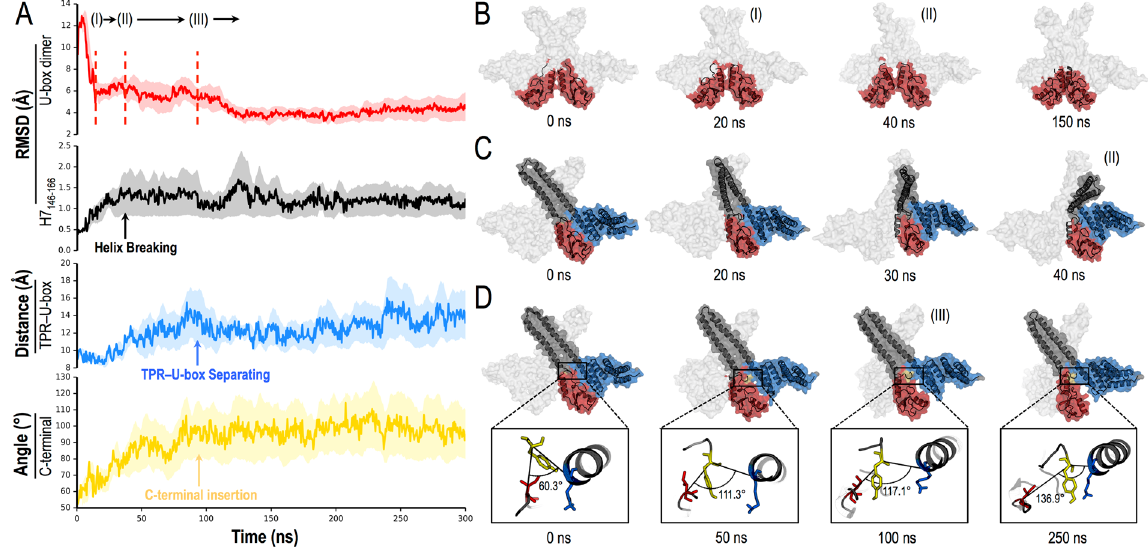
Figure 4. Molecular dynamics of HH-chimeric-dimer model reveals that U-box dimerization drives CHIP symmetry breaking. ( A ) Time progression of dimerization of HH-dimer-first chimeric model (see Fig. 3A) averaged over three independent runs (shades indicate standard deviation). Following the notation in Fig. 3B,C and D, we show: RMSD relative to the crystal structure of the U-box dimer, RMSD of the breaking region in H7, TPR-U-box separation, and the C-terminal angle between the vector joining the C-alpha’s of TPR K145 (blue stick) with C-terminus Y304 (yellow stick), and U-box I228 (red stick) and Y304, as a function of time. MDS snapshots at relevant time scales of ( B ) U-box dimerization, ( C ) breaking of H7, and ( D ) TPR–U-box separation with a magnified C-terminal insertion. Light gray mesh denotes the second monomer. See also Supplementary Video S1 of unconstrained MDS showing transition from symmetric to asymmetric